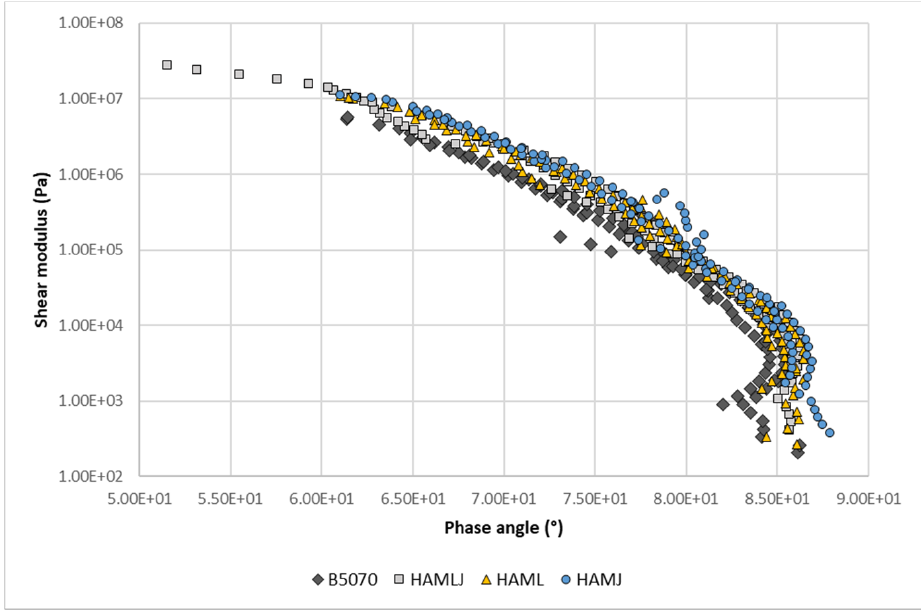
Figure 9. Black diagram comparing the hot asphalt mastics and B5070.